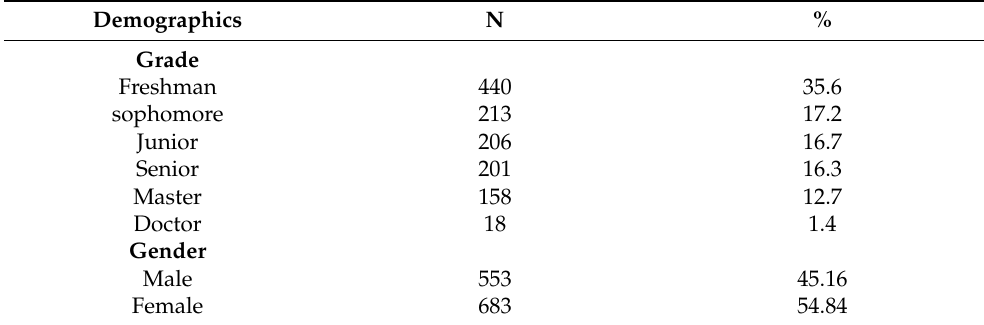
Table 1. The sample